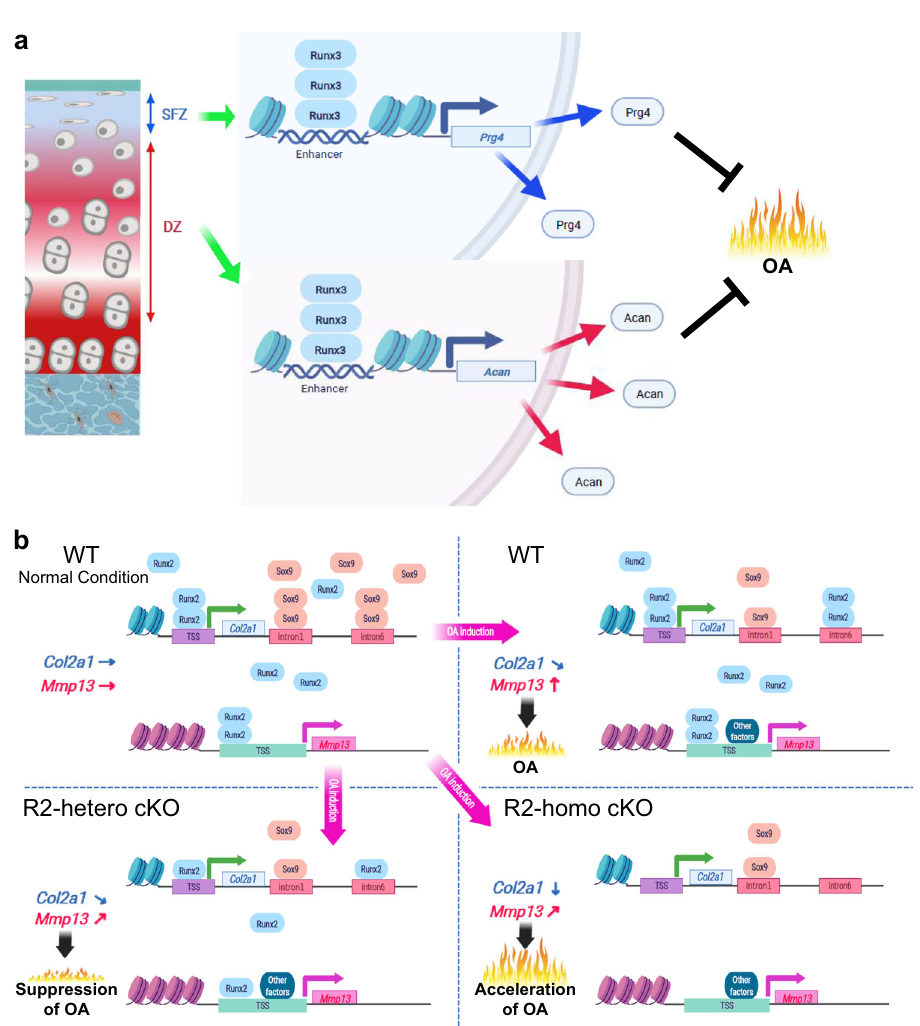
Fig. 8 | Schematic diagrams representing molecular pathways in which Runx3 and Runx2 regulate articular cartilage during OA development. a Runx3 con- tributes to cartilage homeostasis throughthe inductionofPrg4and Acan. b